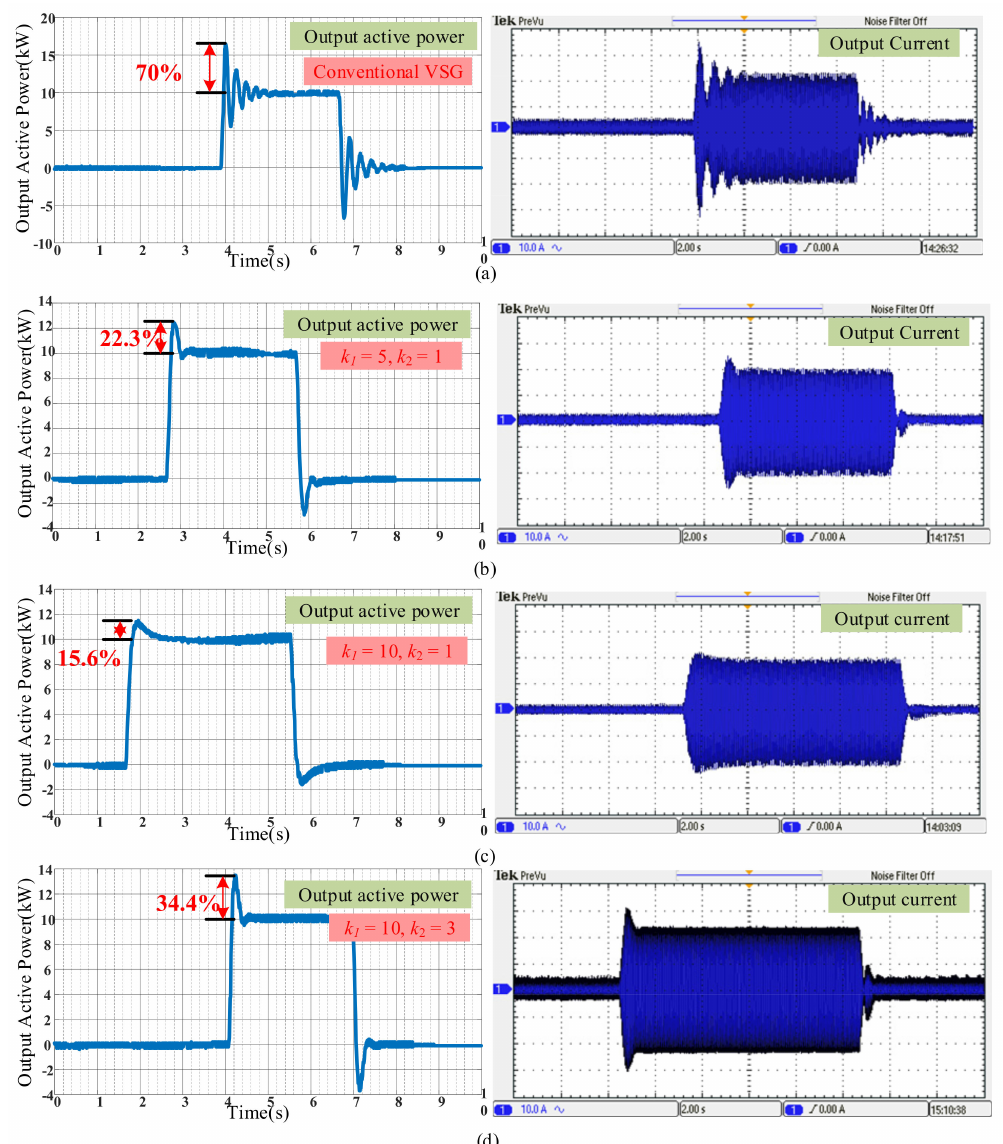
Figure 19. Experimental results in GC mode: ( a ) conventional VSG; ( b ) k 1 = 5, k 2 = 1; ( c ) k 1 = 10, k 2 = 1; ( d ) k 1 = 10, k 2 =